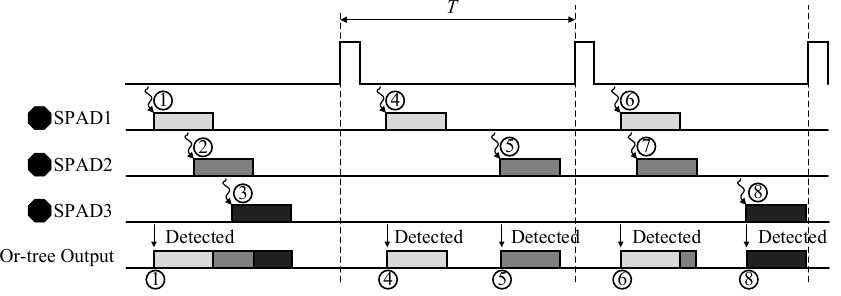
Figure 6. The schematic diagram of pile-up effect.